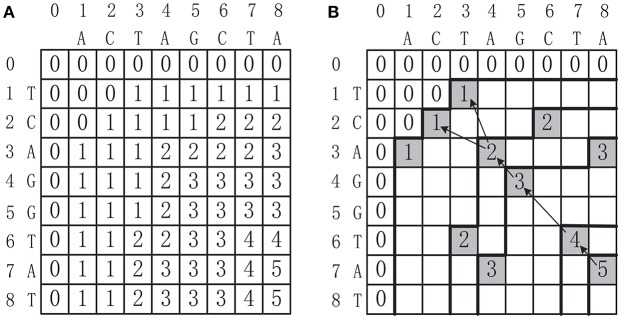
(A) The score table of two DNA sequences ACTAGCTA and TCAGGTAT. (B) Constructing the MLCS from the score table, where the shaded cells conspond to dominant points.